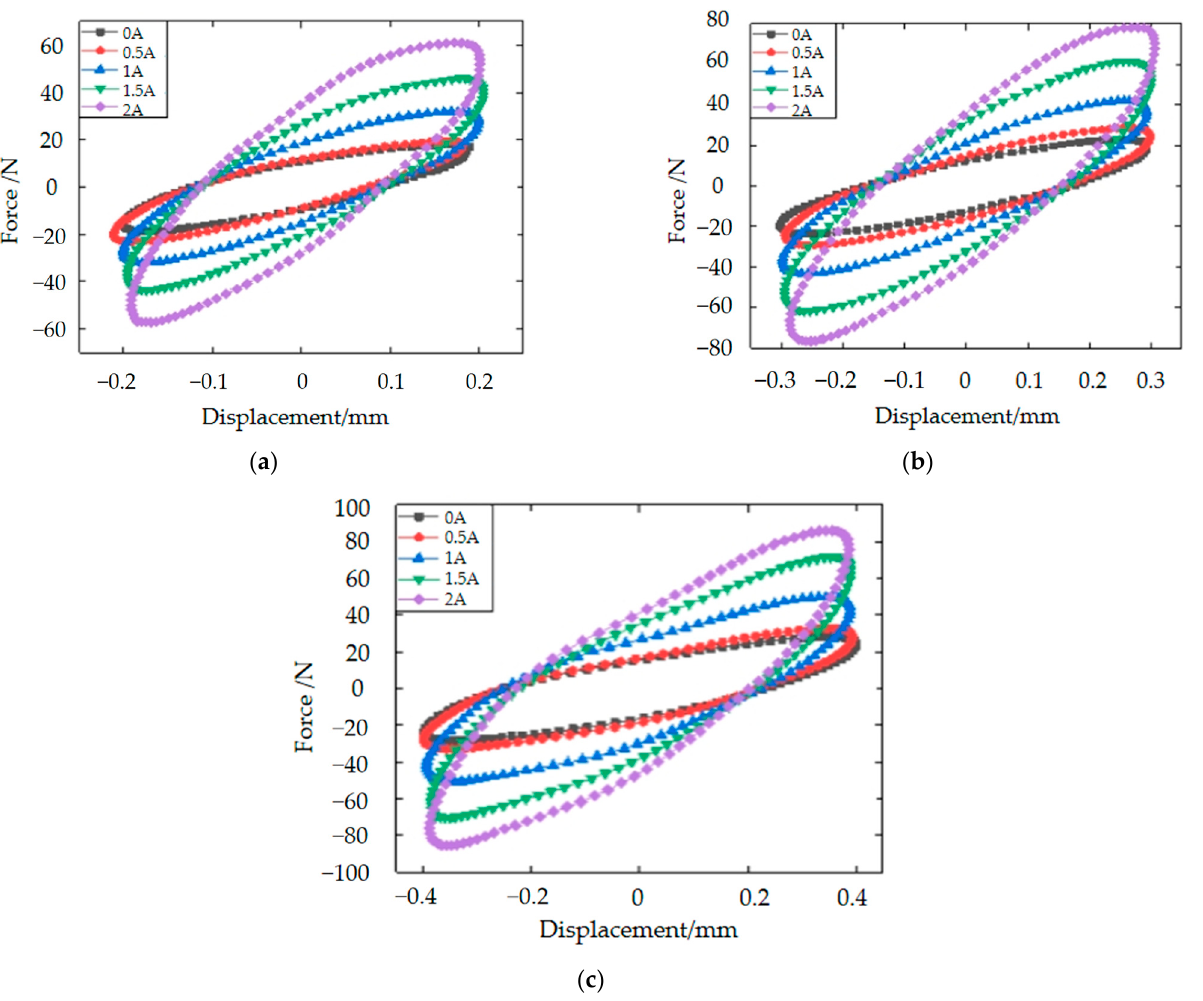
Figure 10. Force–displacement hysteresis loops in the vertical direction of the MRE isolator for 8-Hz excitation: ( a ) 8 Hz, 0.2 mm; ( b ) 8 Hz, 0.3 mm and ( c ) 8 Hz, 0.4